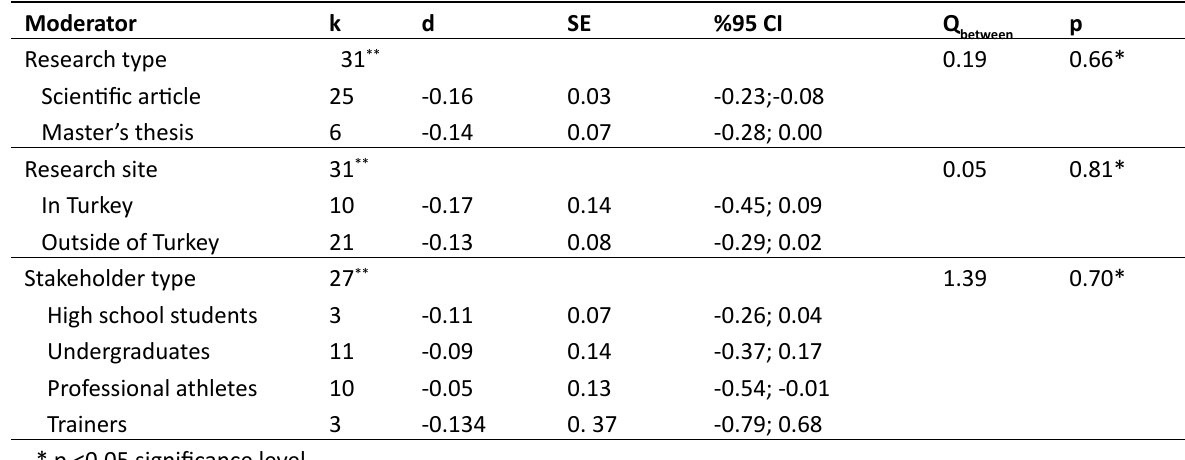
Figure 3. Forest Table 3. Categorical moderator results on the effect of gender on nutrition knowledge